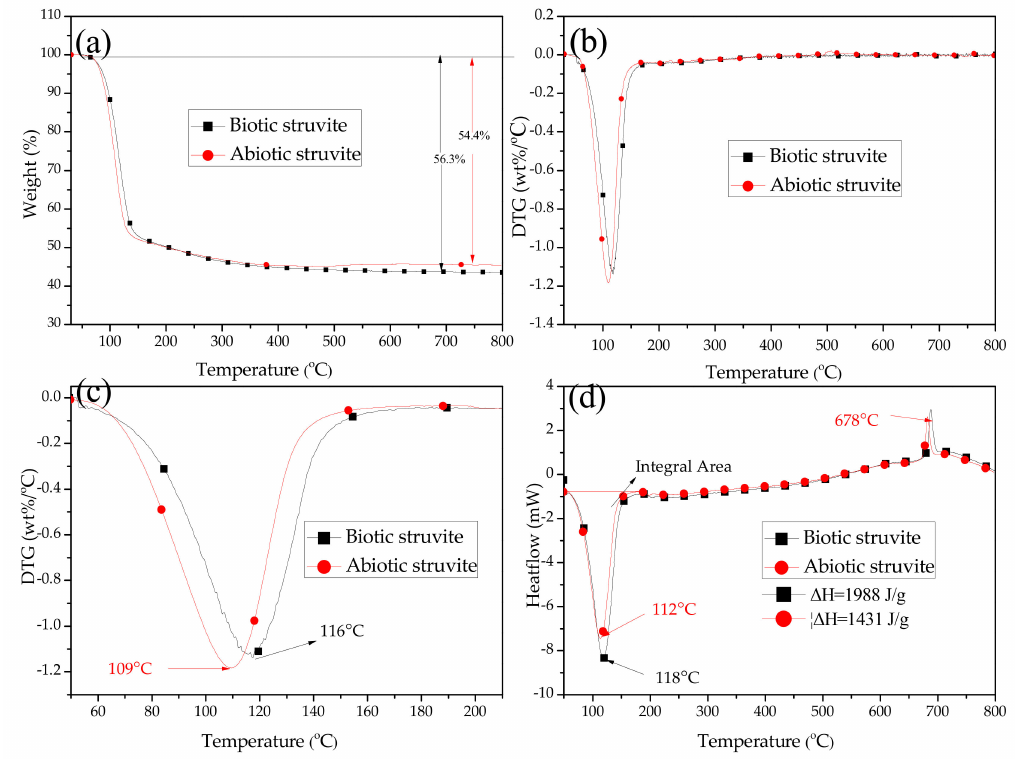
Figure 10. TG ( a ), DTG ( b , c ) and DSC ( d ) analyses of struvite induced by the bacterium